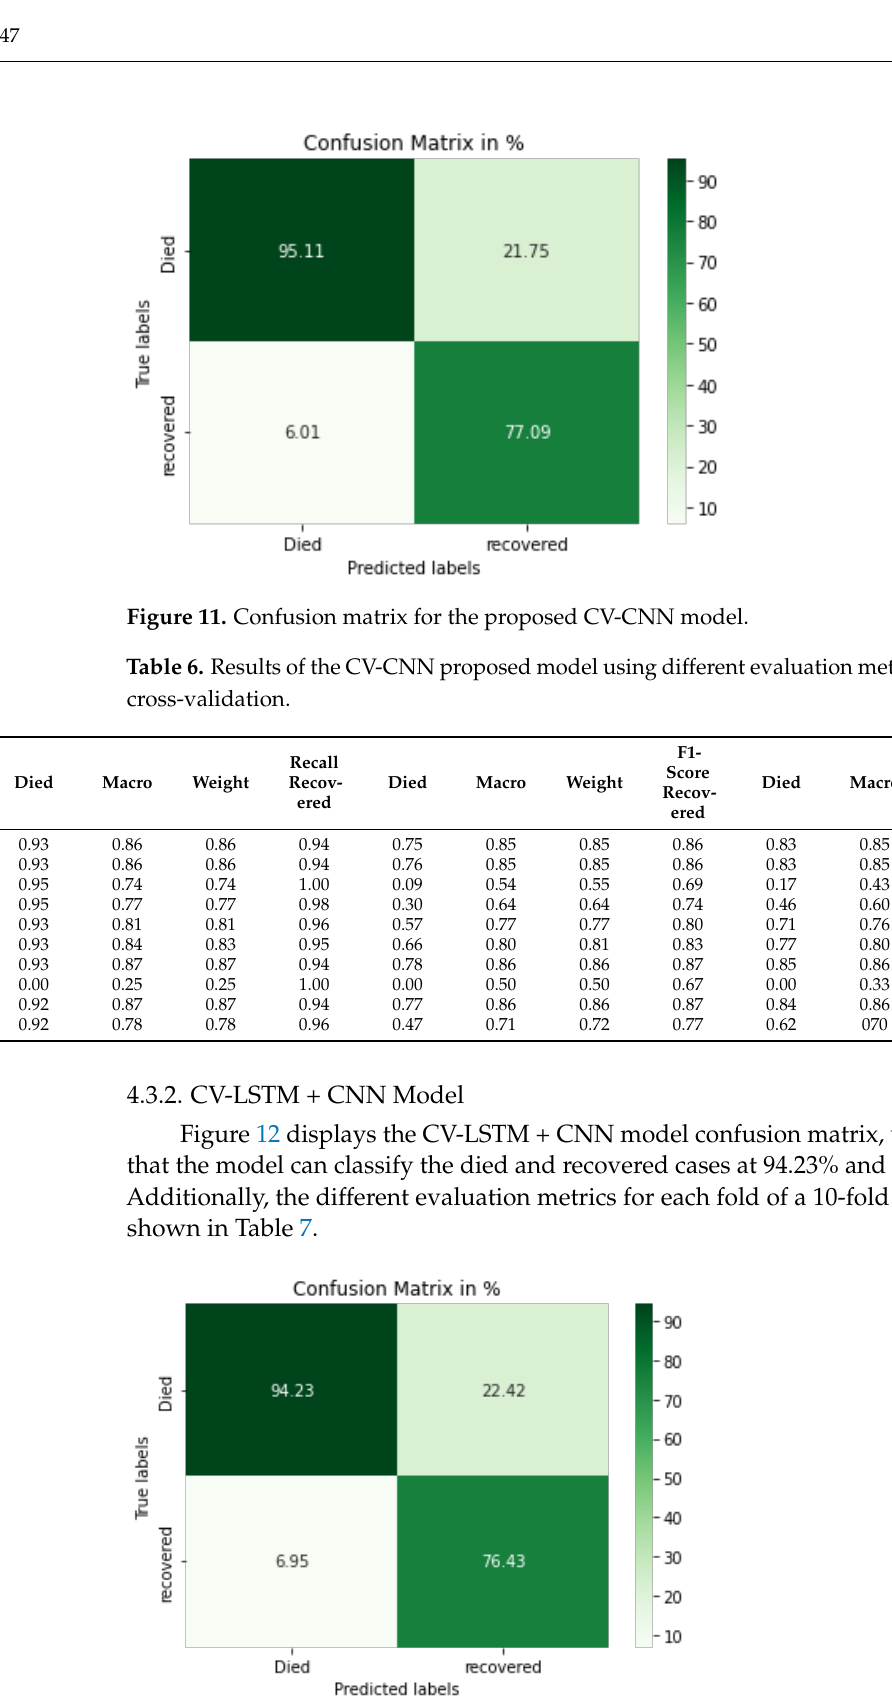
Figure 12. Confusion matrix for the proposed LSTM+CNN